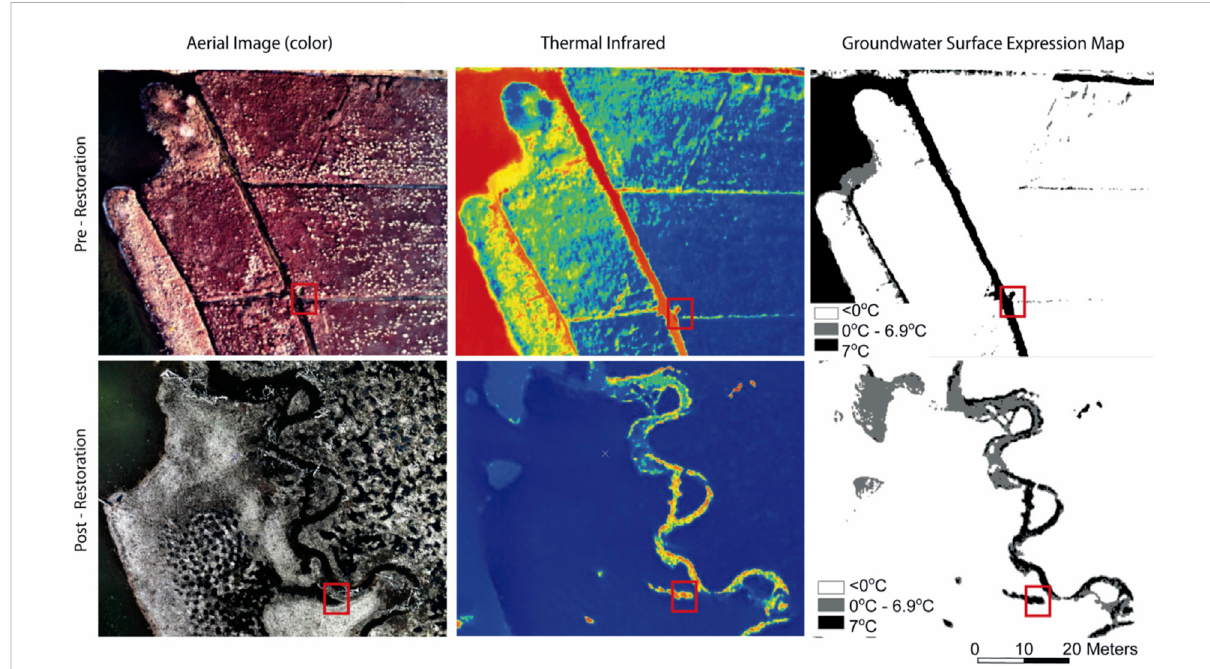
FIGURE 8 Comparative UAS imagery from pre-restoration (top row) to post-restoration at Foothills Preserve, from left to right: (left) plain light (RGB image), (center) thermal infrared, and (right) surface expression of groundwater (black = groundwater and gray = mixing zone). This fi gure shows an area where the channel was reconstructed from a series of ditches into a meandering channel. The red box indicates a single groundwater seep whose fl ow direction changed with the movement of the stream